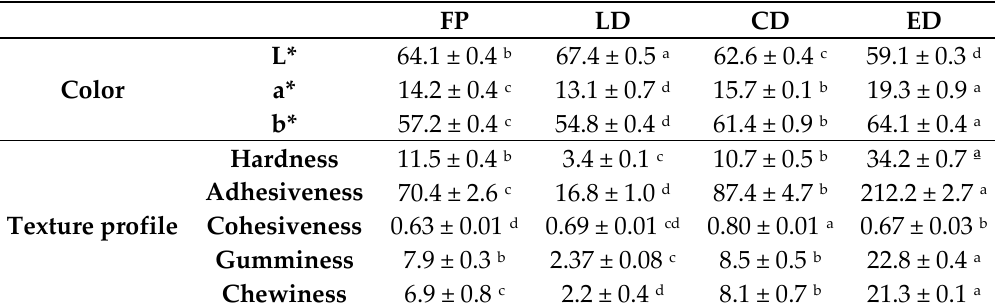
Table 3. Color and texture profile of the rehydrated